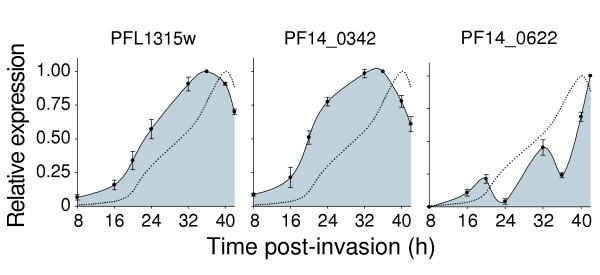
Stage-dependent gene expression of two P. falciparum putative K+ channels (PFL1315w and PF14_0622) and the putative novel ion channel (PF14_0342) of the voltage-gated ion channel superfamily, throughout the intraerythrocytic cycle of P. falciparum. The analysis was carried out as described in the legend to Figure 4.